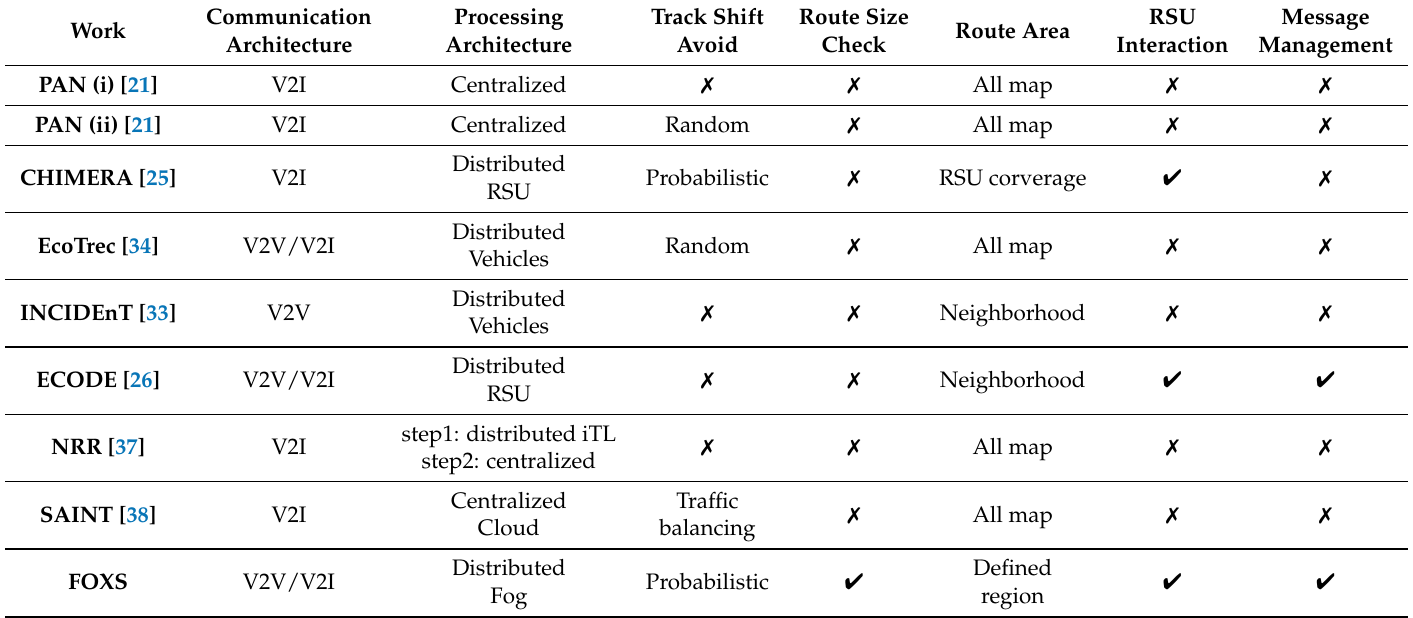
Table 1. Comparative of related